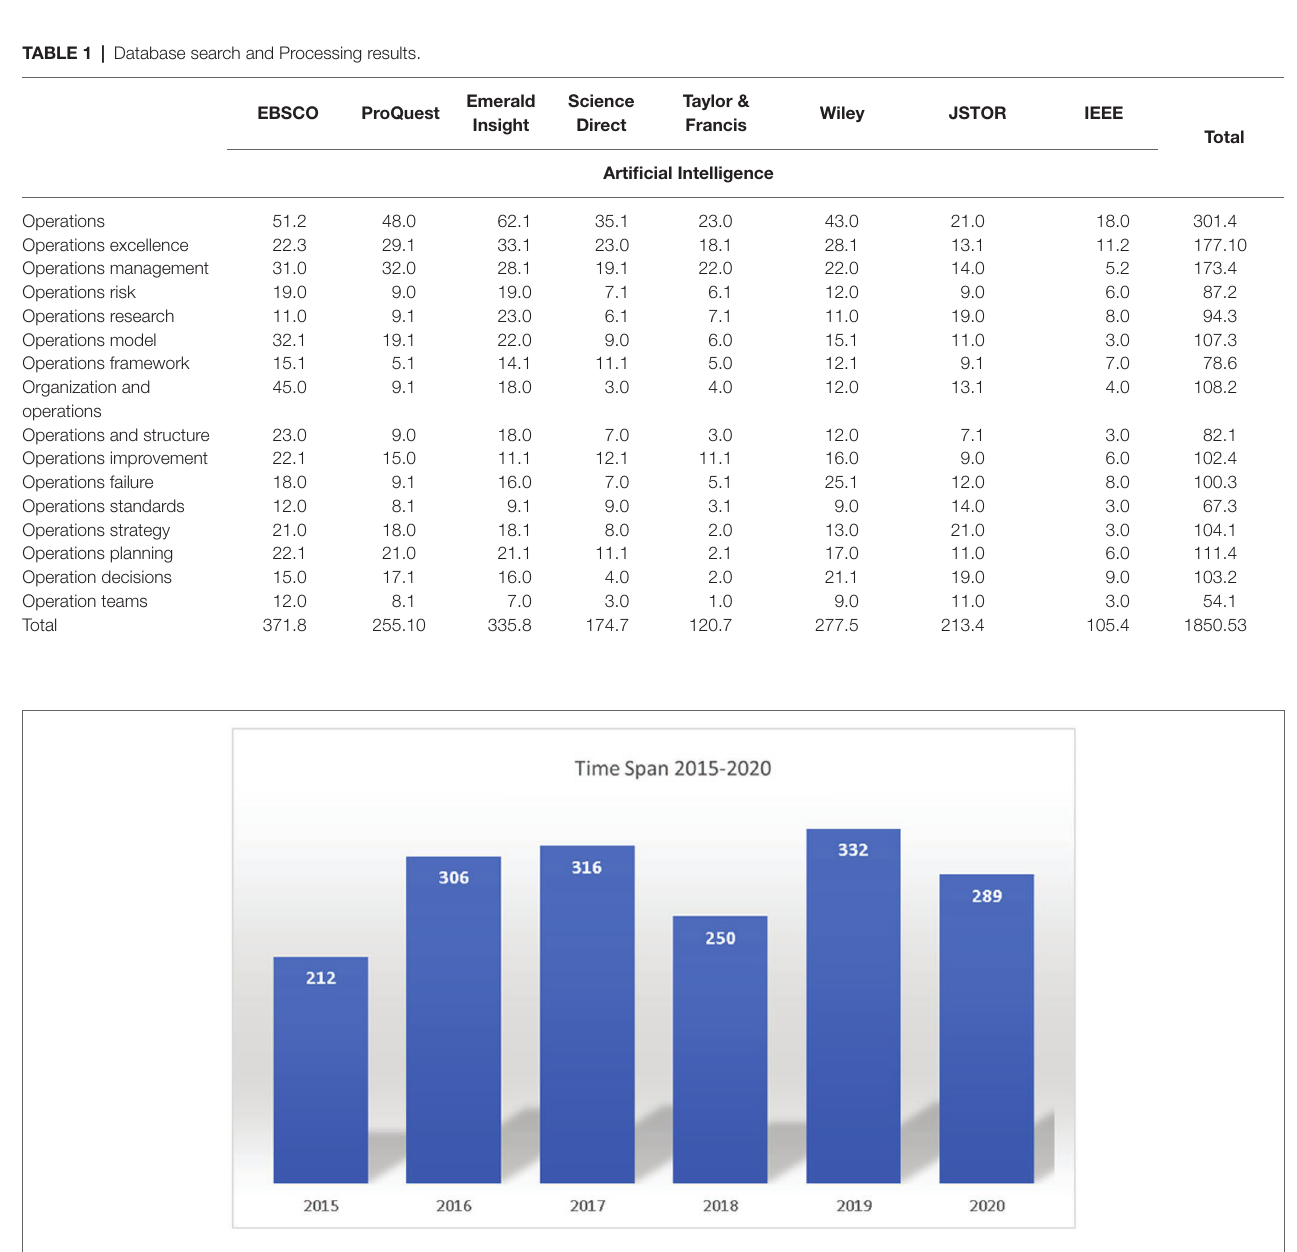
FIGURE 4 | Time span for identified articles.